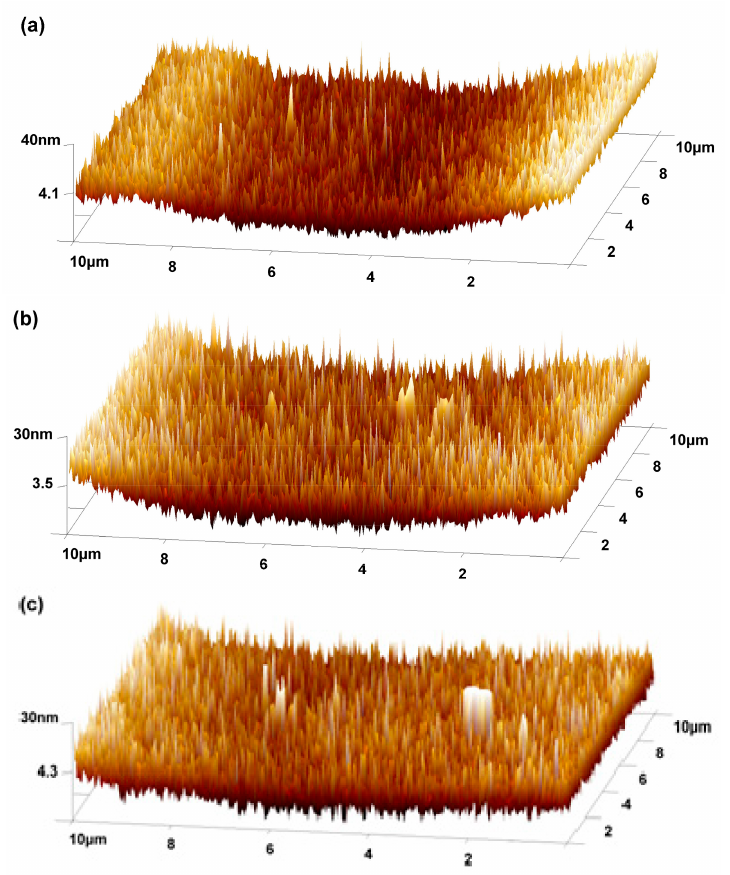
Figure 19. Wear scars of samples: ( a ) deposited Ti substrate, ( b ) GO-APS coating and ( c ) HRGO-APS